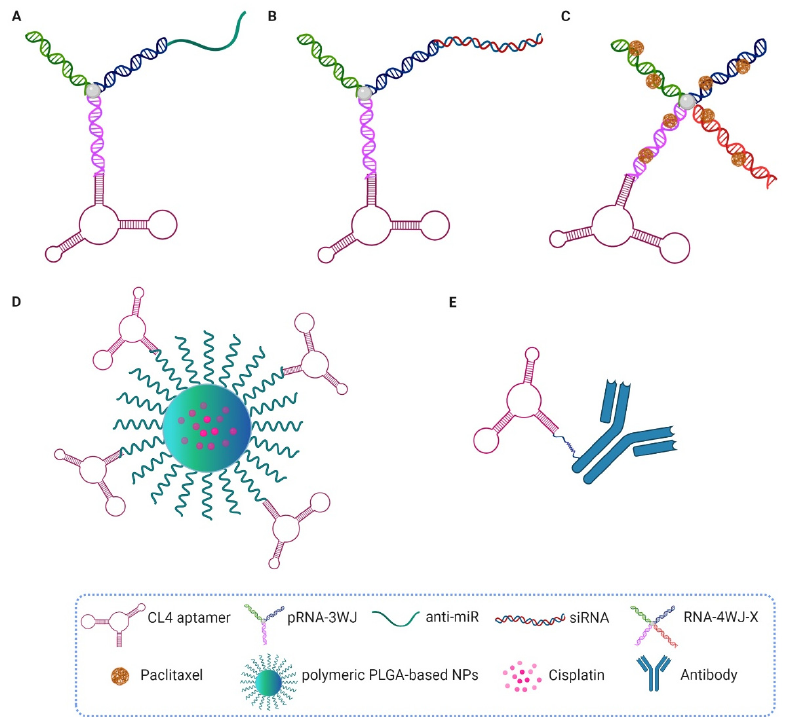
Figure 3. Schematic representation of the anti-EGFR CL4 aptamer-based conjugates. ( A ) 3WJ-CL4/anti-miRNA-21 nanoparticles. ( B ) 3WJ-CL4/siRNA-XBP1 nanoparticles. ( C ) 4WJ-CL4/paclitaxel nanoparticles. ( D ) CL4-PNPs/cisplatin. ( E ) CL4-antibody (see text for details) . This figure was created by BioRender.com (accessed date 12 October 2021).